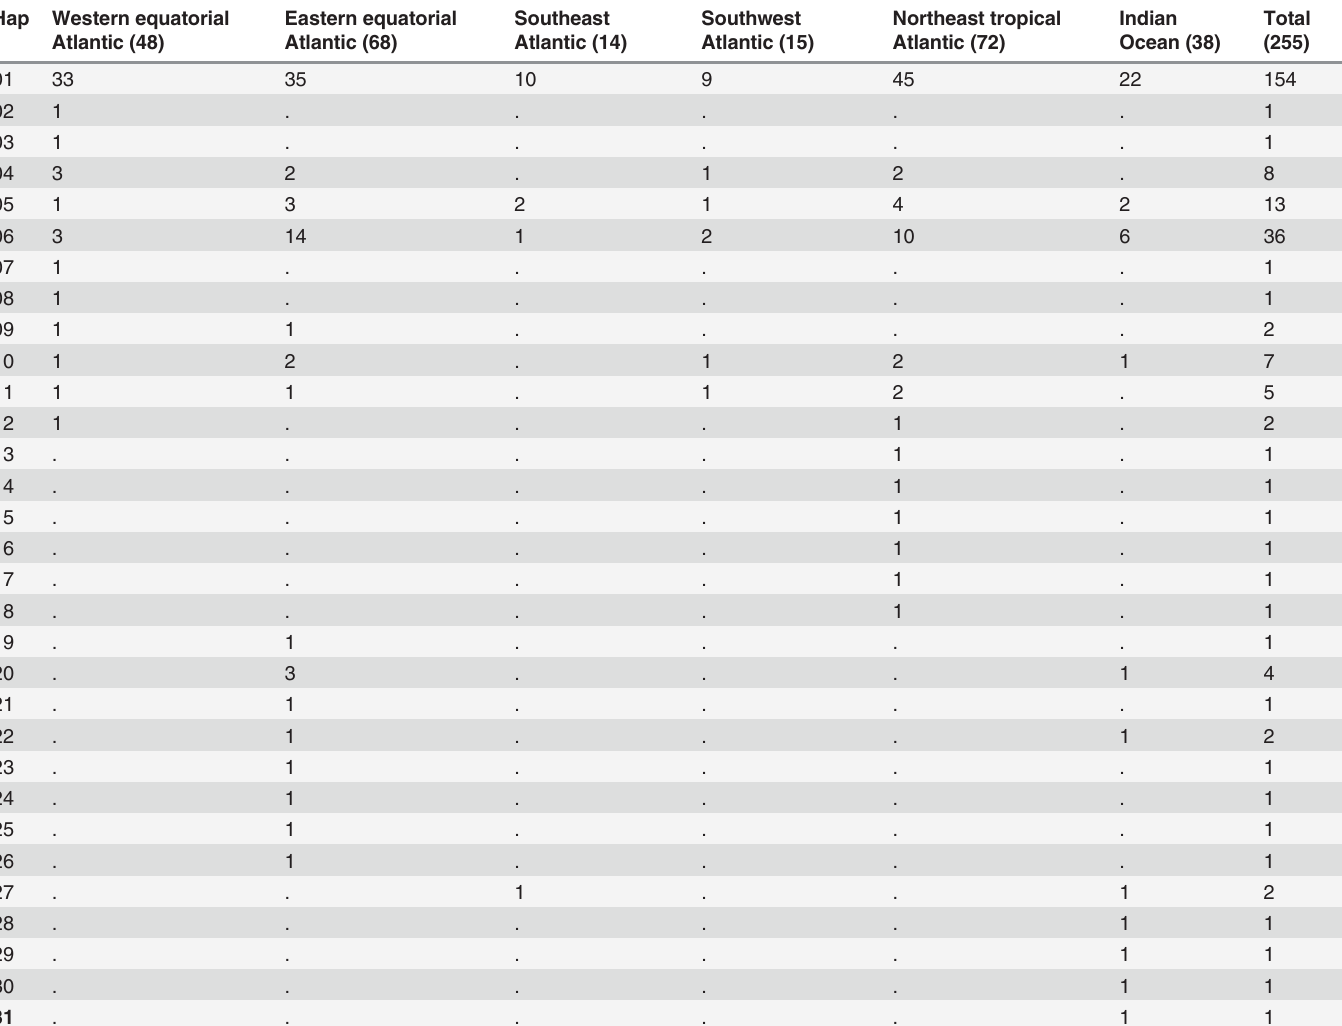
Table 2. Geographical distribution of haplotypes of P. kamoharai , in number of specimens per region. Hap Western equatorial Atlantic